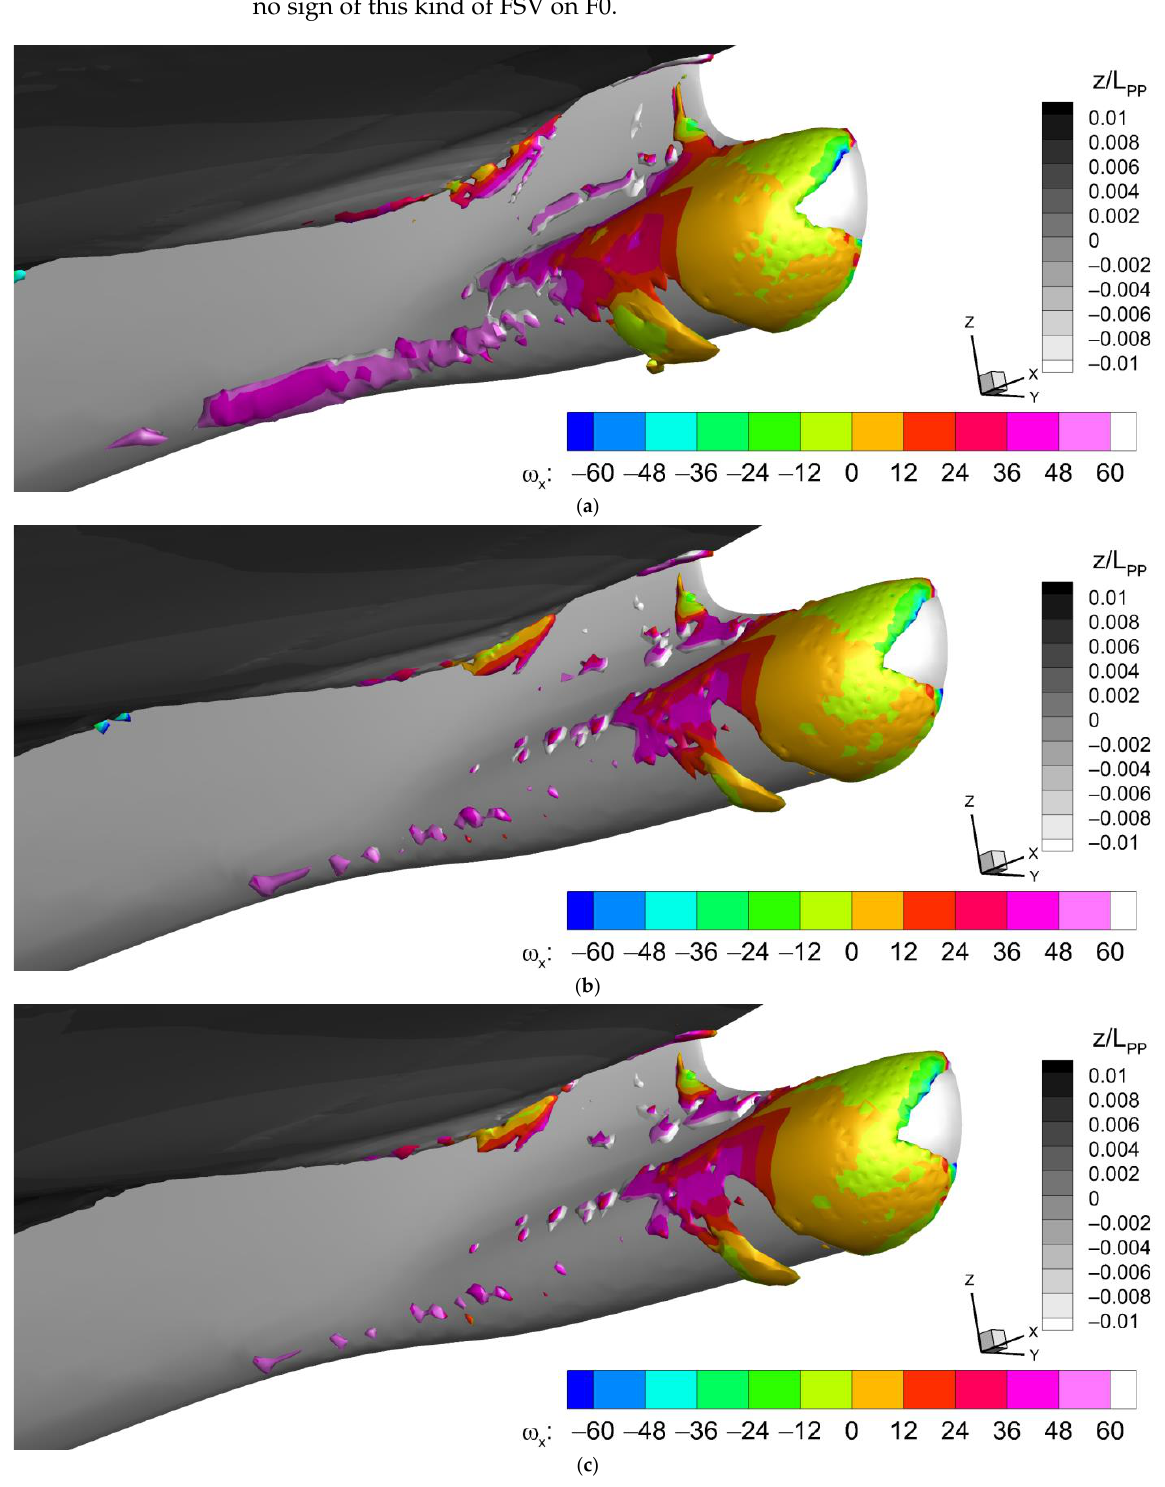
Figure 17. Vortical structure around different lengths of sonar dome (isosurface of Q = 500) with the contour flooded by the color of x -vorticity ω x ; ( a ) F0.14; ( b ) F0.225; ( c ) F0.24.